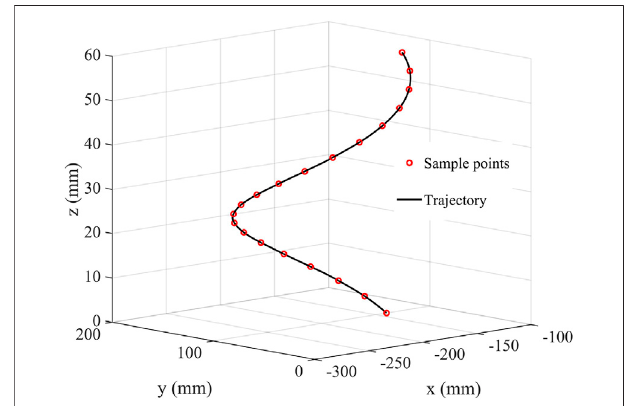
FIGURE 9 | The trajectory of